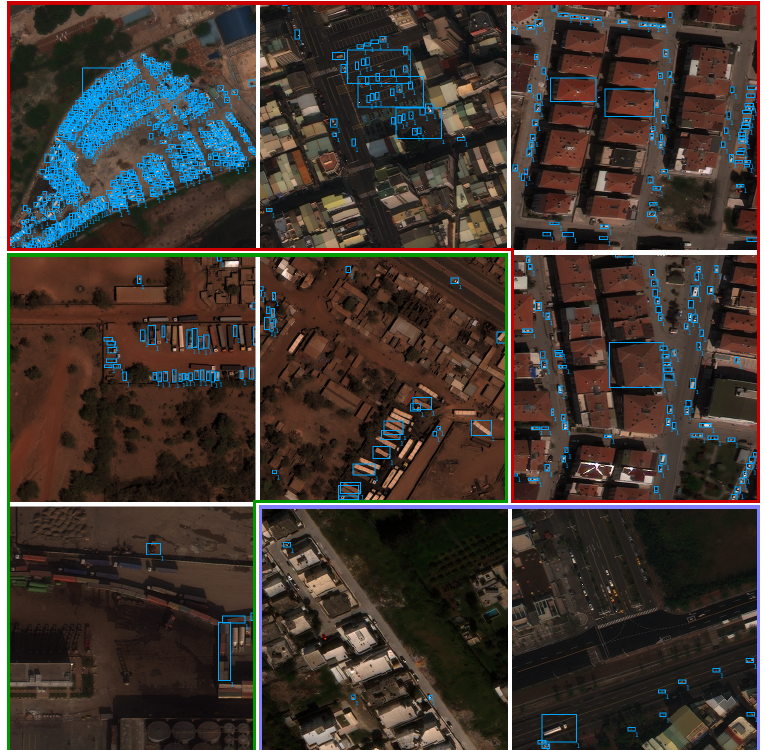
Figure 7. Examples of faulty annotations in the xView dataset: non-vehicle annotation (red border ), missing annotations of container trucks (green border), and cars (blue border). The number and color of each box indicates the vehicle